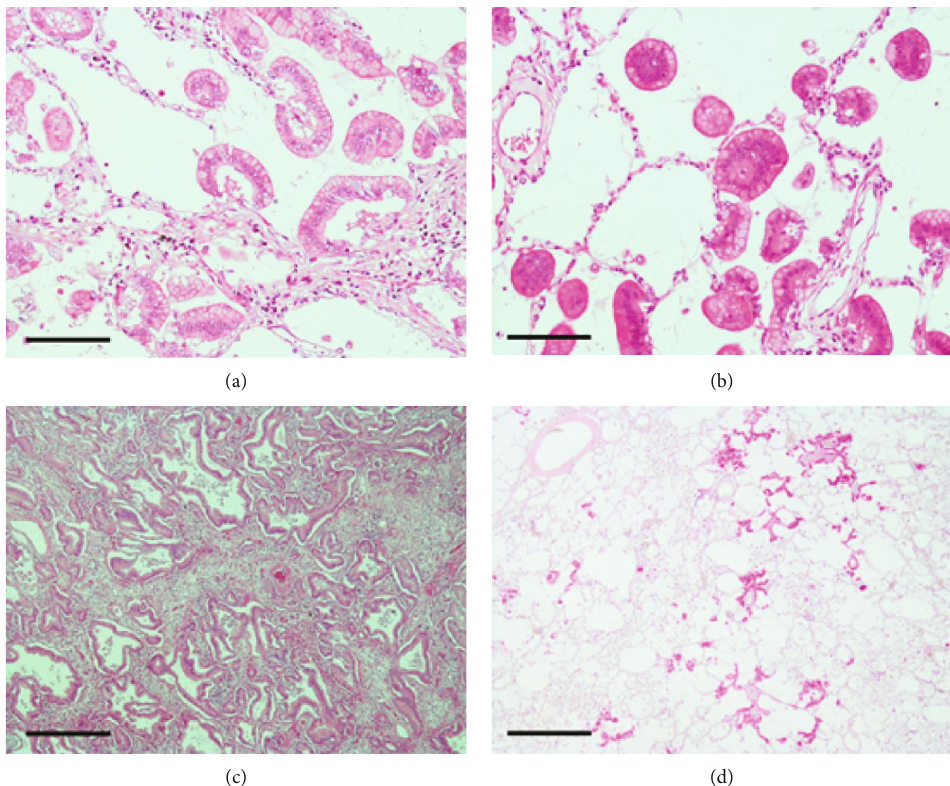
Figure 3: Left lung cancer II. (a) Small groups of tumor cells that detached from the alveolar wall. Only a slight in fl ammatory cell in fi ltration is visible. H&E stain, scale bar: 200 μ m. (b) Detached tumor cells with a micropapillary pattern fl oat within the alveolar spaces. H&E stain, scale bar: 200 μ m. (c) The invasive component exhibits glandular or papillary growth. H&E stain, scale bar: 1mm. (d) Many scattered tumor cell aggregates that detached from the primary tumor are visible within the air spaces and on the alveolar wall. The latter aggregates exhibit lepidic or papillary growth that is suggestive of microscopic aerogenous metastases. H&E stain, scale bar: 2